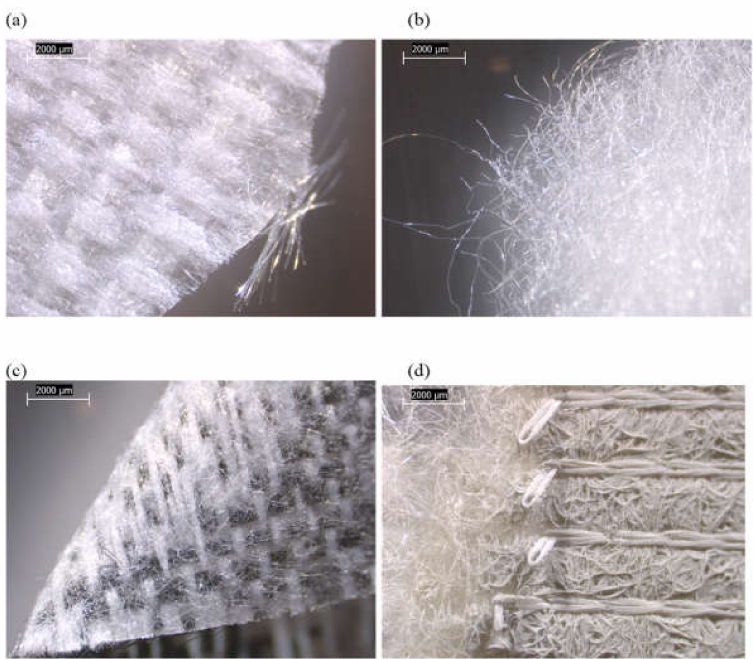
Figure 2. Low-power reflected-light stereozoom microscope images of FG-1 mattress subsamples acquired at 10 × . ( a ) Synthetic, woven outer cover material from top side of mattress. ( b ) Synthetic, fibrous mat beneath outer cover material from top side of mattress. ( c ) Synthetic, woven outer cover material from side of mattress. ( d ) Outer cover material from bottom of mattress with fibrous mat, foam coating, and woven